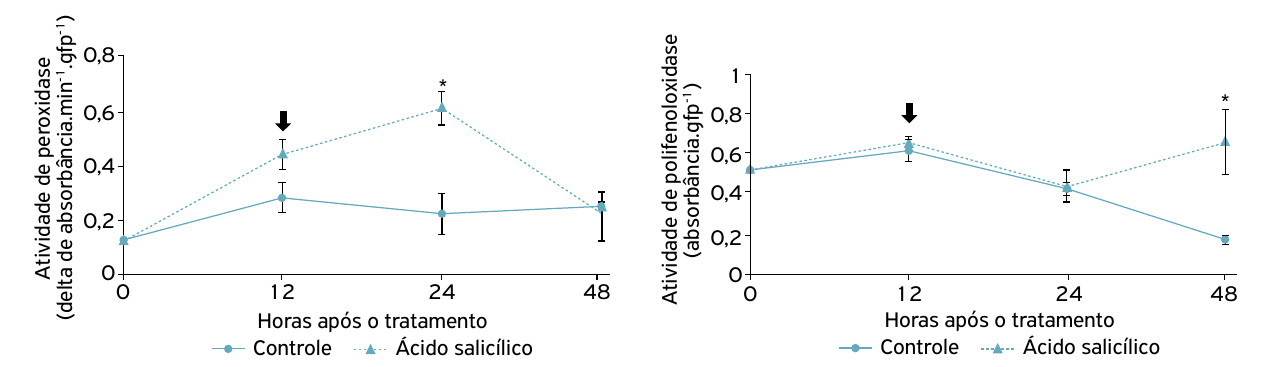
Figura 2. Severidade do endurecimento dos frutos em maracujazeiro‑amarelo em função do tratamento com ácido salicílico 2,5 mM e controle (etanol 10%), pulverizados semanalmente em um total de quatro aplicações, em condições de casa de vegetação.